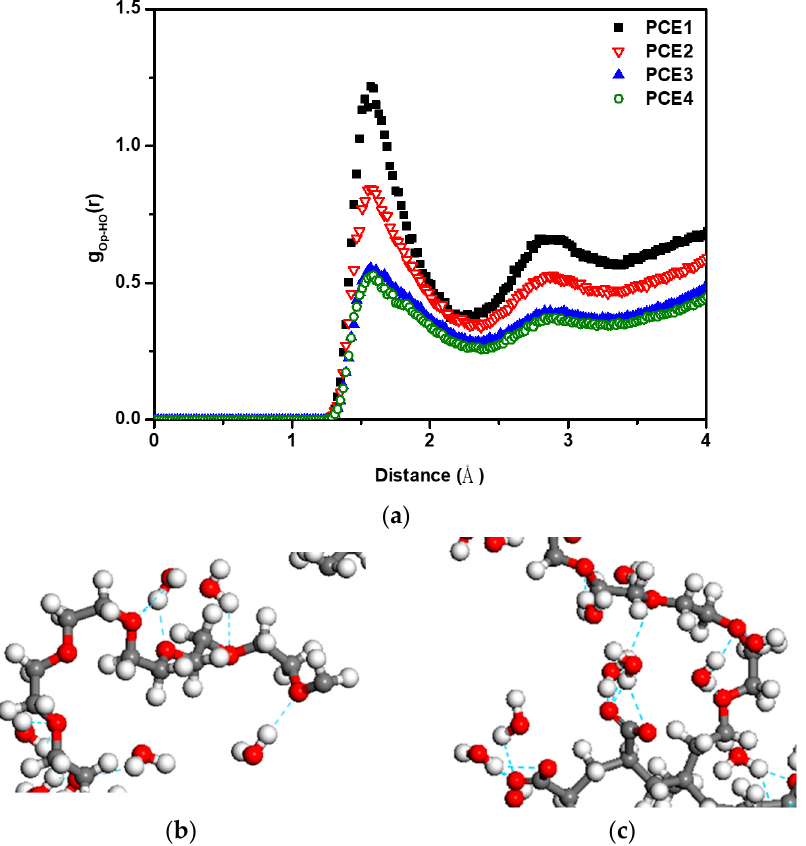
Figure 6. ( a ) The RDF g Op-HO (r) in PCE aqueous systems, ( b ) part of hydrogen bonds on the side chain of PCE, and ( c ) part of hydrogen bonds around the main chain of PCE.